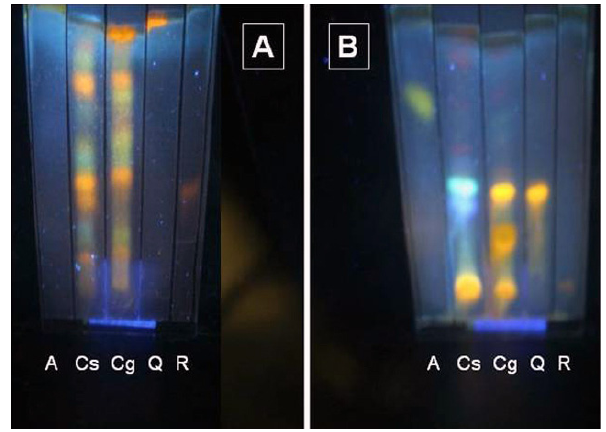
Figure 1. Comparative thin layer chromatography between Casearia sylvestris (Cs) and Casearia gossypiosperma (Cg). Chromatographical profile of extracts and phytochemical standards under solvents A (ether acetate:formic acid:water, 9:1:1, v/v) and B (acetone:chloroform:formic acid, 10:75:8, v/v). Note the similarity of compounds between ( A ) Casearia spp. and the presence of rutin and quercetin and another unidentified orange compound in ( B ) C. gossypiosperma . A: apigenin; Q: quercetin; R: